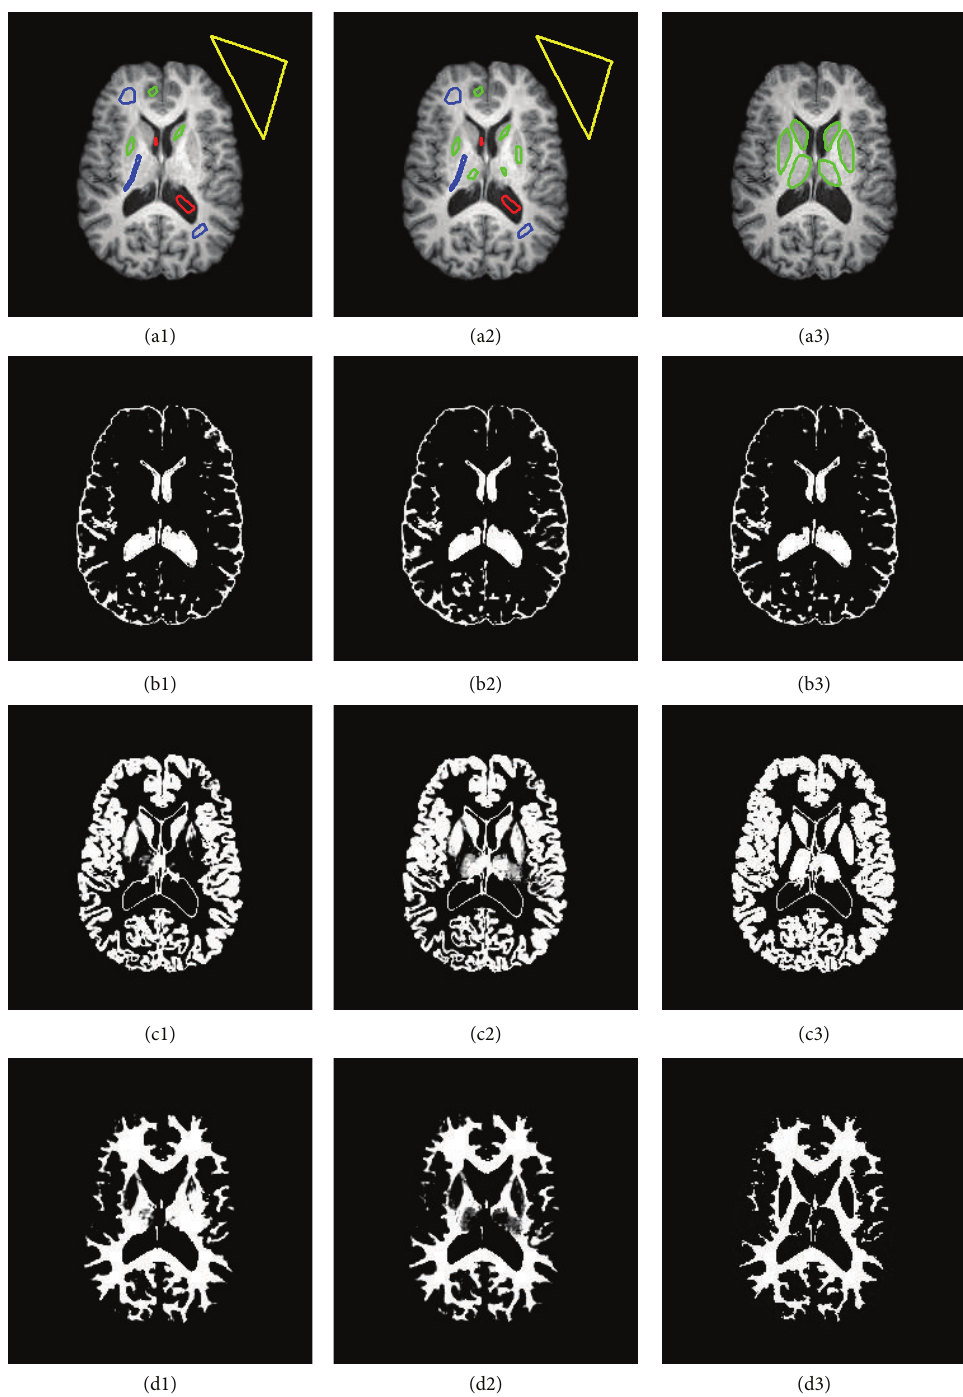
Figure 8: Comparison among supervised method with less known regions, supervised method with more known regions, and the ground